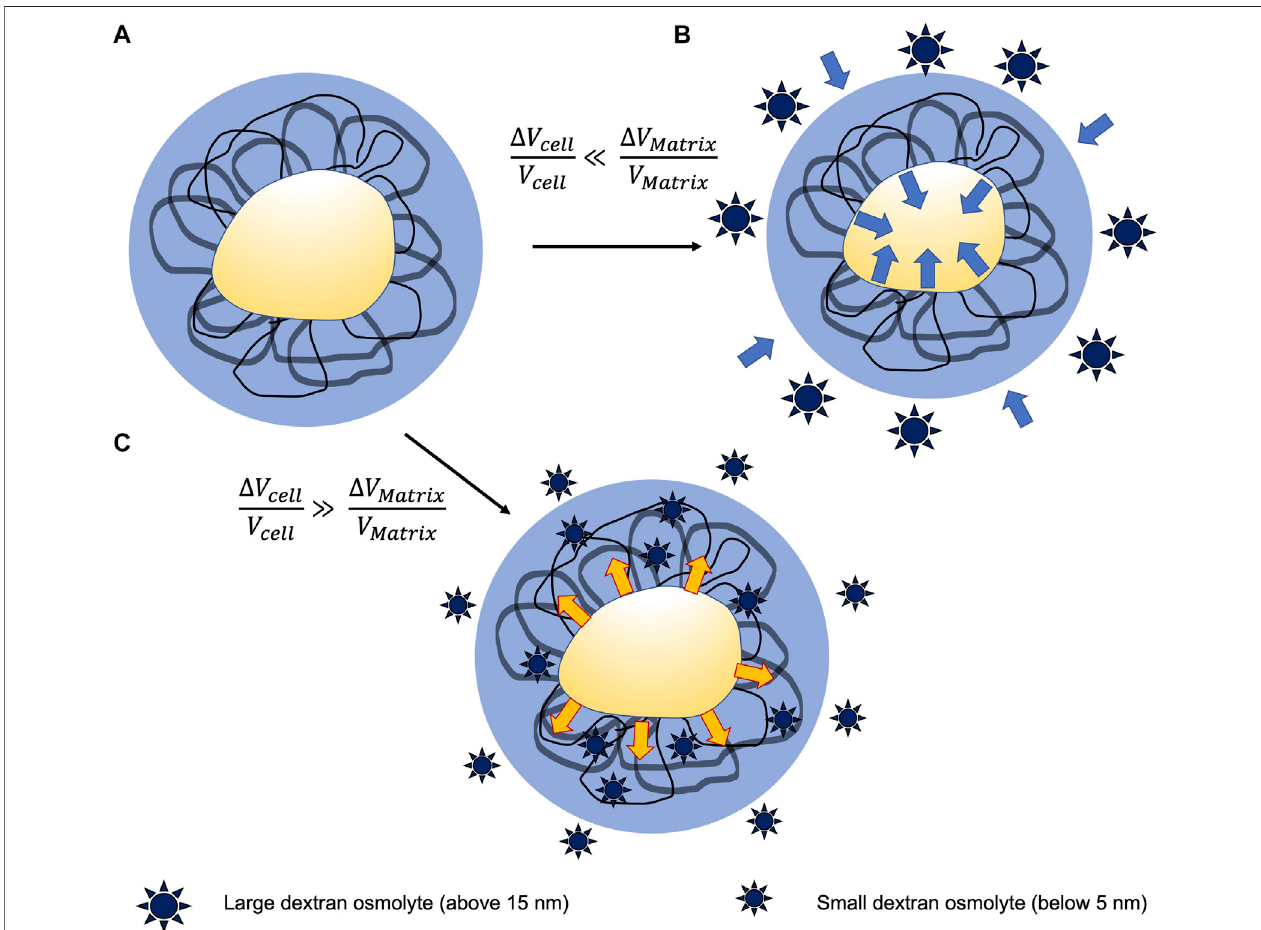
FIGURE 8 | Interplay between cell aggregates and their matrix surrounding modeled through a selective compression technique. (A) Schematic drawing of a cell surrounded by the extracellular matrix fi laments and permeated through the interstitial liquid. (B) Large osmolytes cannot penetrate the extracellular matrix scaffold and thereby a bulk compression is imposed toward the cell. Since the extracellular matrix is more compressible compared to the incorporated cells, the extracellular matrix effectively soaks up the majority of the deformation and imposes a positive stress on the cell. (C) Small osmolytes can penetrate the extracellular matrix scaffold in the absence of any osmotic pressure. However, they compress the cell that, in turn, transmits tension toward the extracellular matrix scaffold.